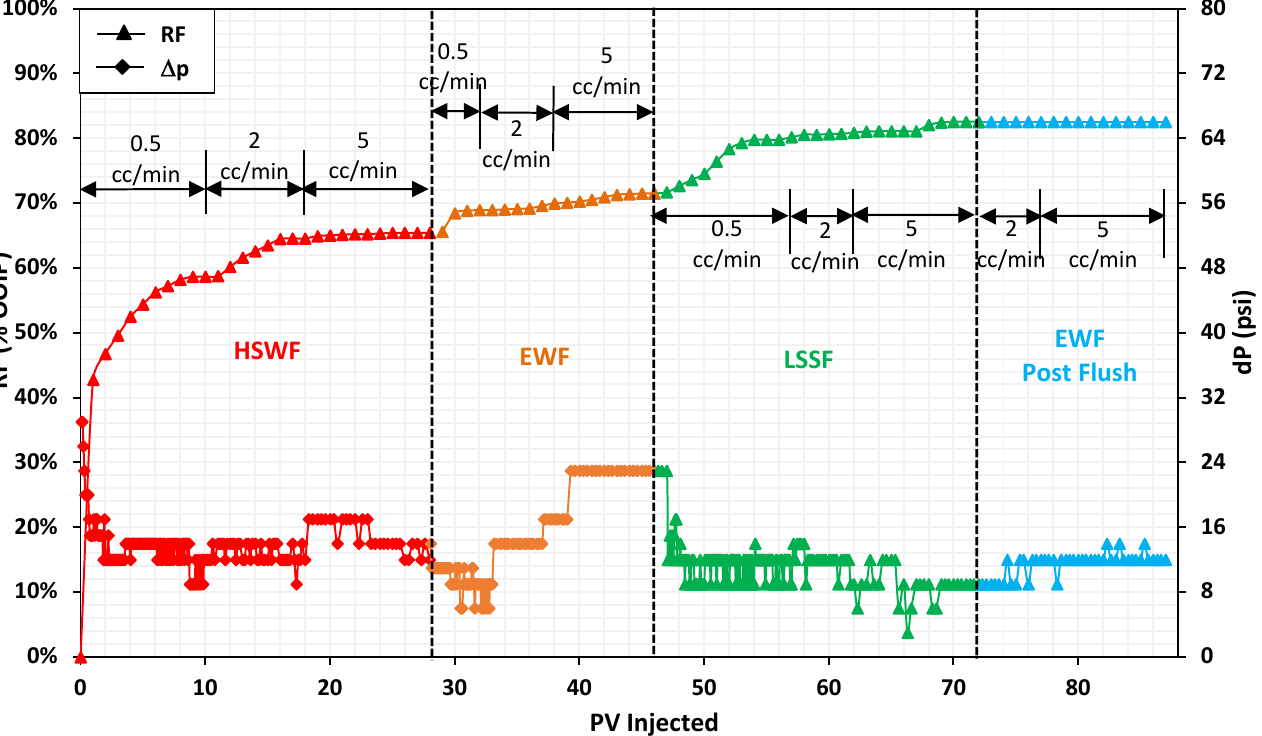
Figure 5. Pressure drop and oil recovery profile for CF-1 with constant salinity profile.